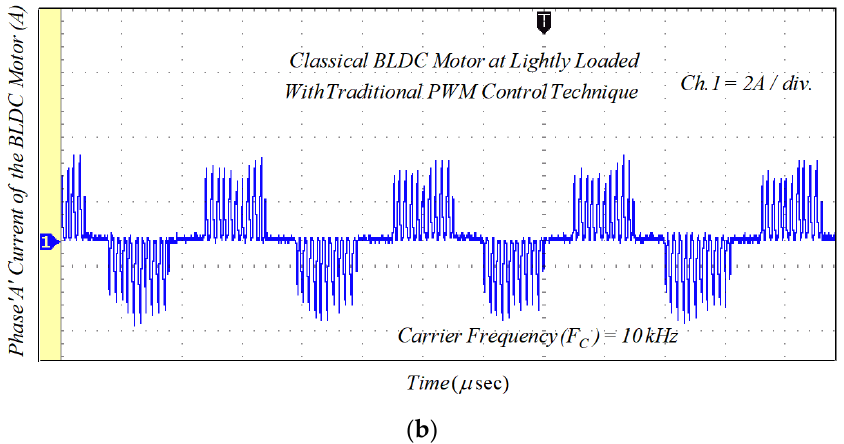
Figure 17. Experimental results of the phase current for classical BLDCM drive with traditional PWM technique: ( a ) lightly loaded condition, 2 A/div.; and ( b ) full load, 5 A/div.